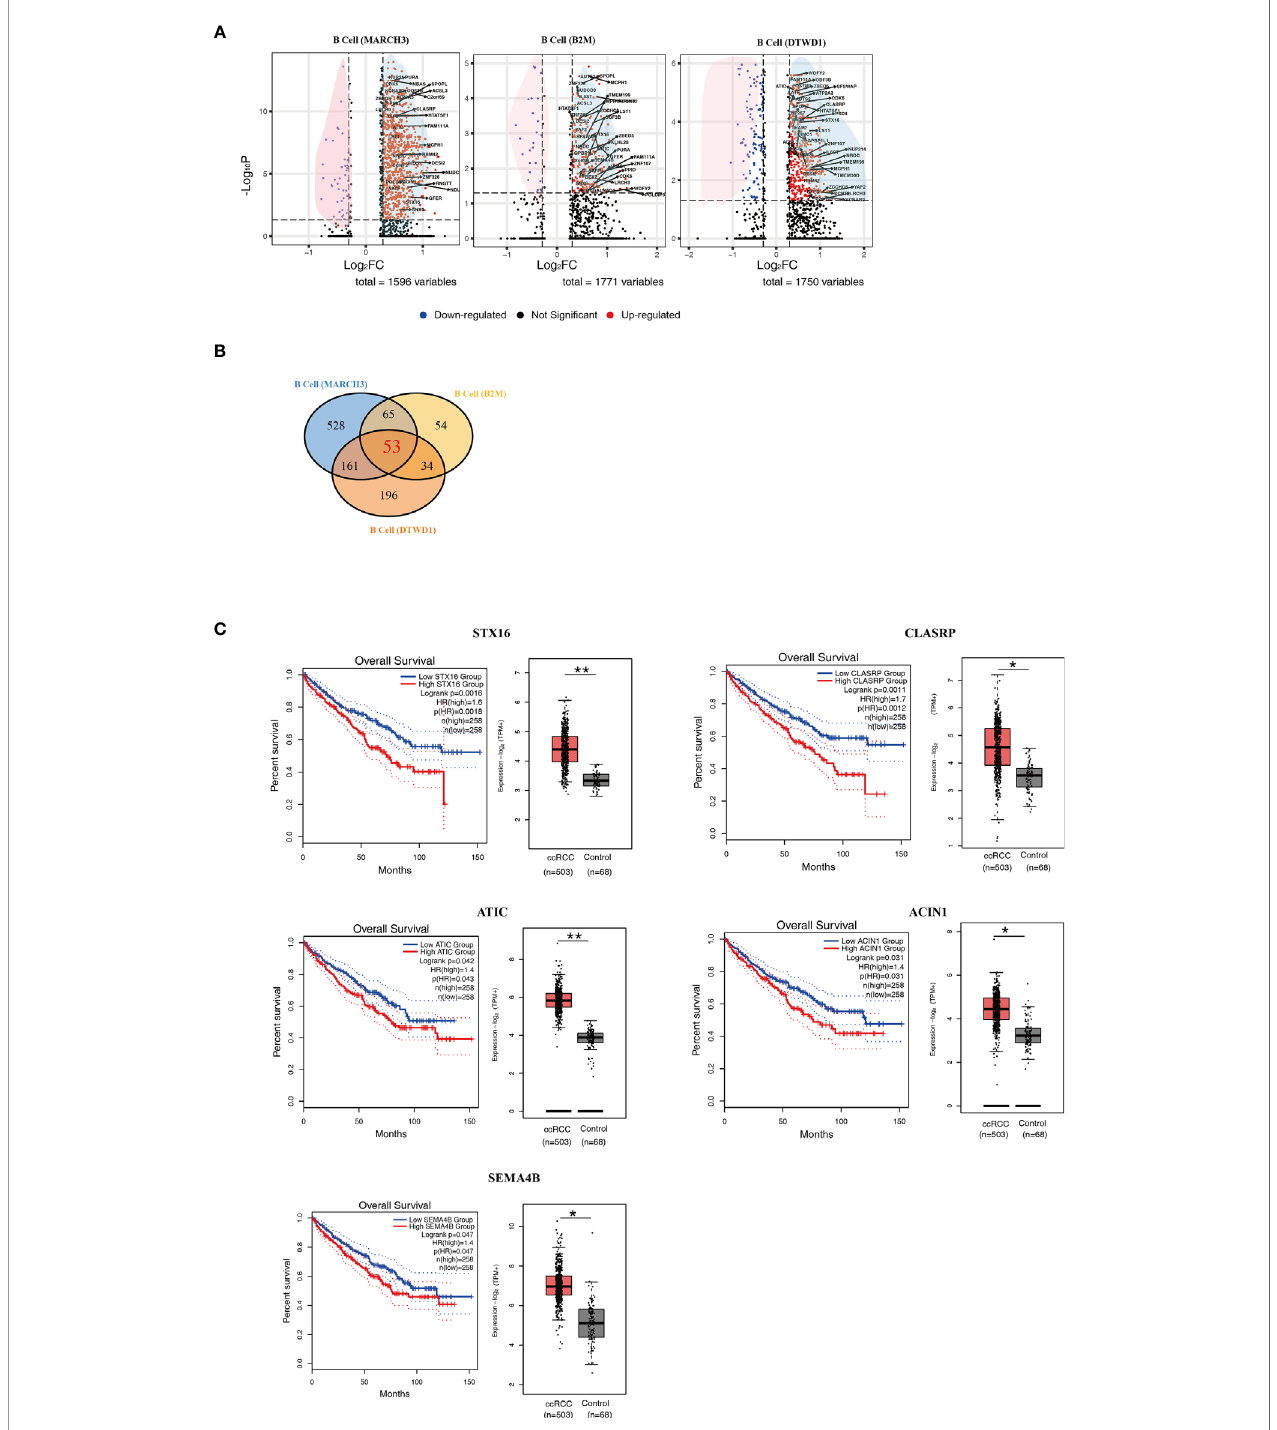
FIGURE 3 | Isolation of Key Genes Associated With Poor Prognosis. (A) Volcano plots showing the distribution of common DEGs (ccRCC vs. control) among B cell subpopulations. (B) A Venn diagram showing the 53 genes up-regulated among the three B cell subpopulations. (C) Survival curves showing the 5 up-regulated genes which correlate with poor prognosis in ccRCC patients. In each panel, the expression level of related genes was presented with box plot. *p<0.05;